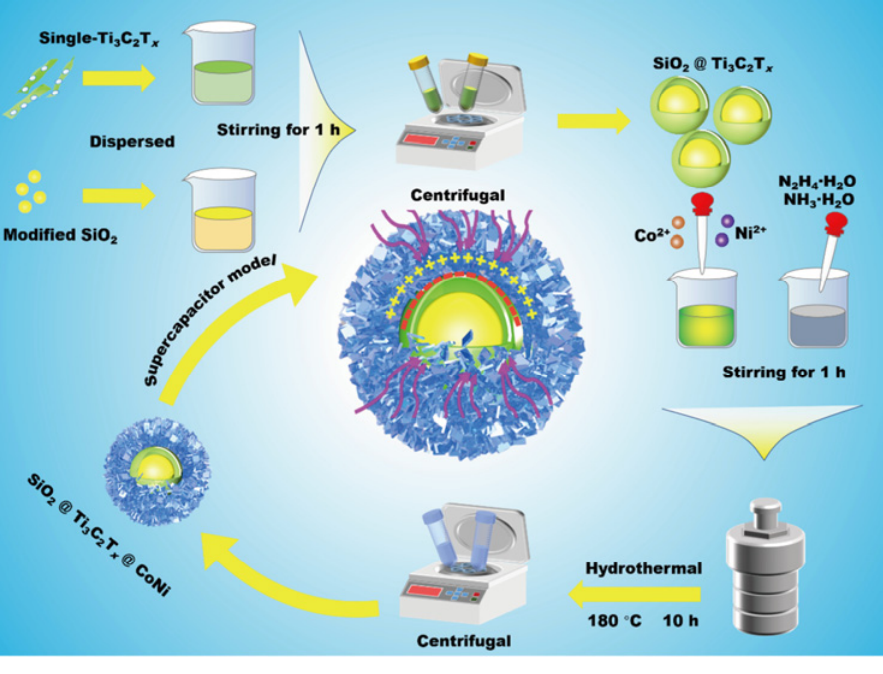
Fig. 1 Illustration of the preparation method for SiO 2 @Ti 3 C 2 T x @CoNi microspheres.